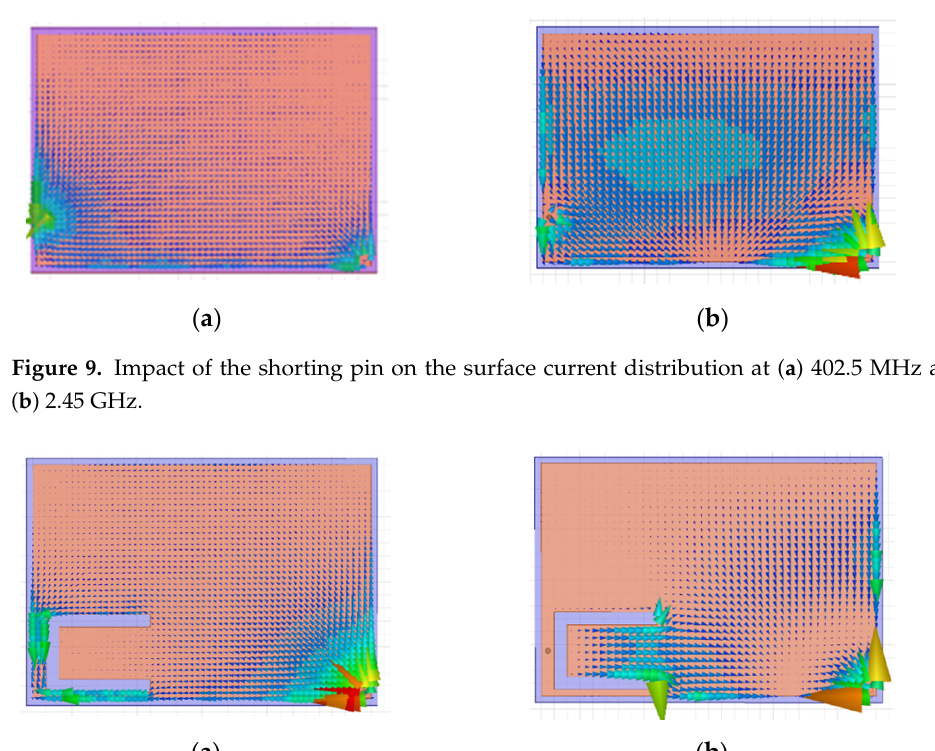
Figure 8. Surface current distribution without elements upon the patch at ( a ) 402.5 MHz and at ( b ) 2.45 GHz.